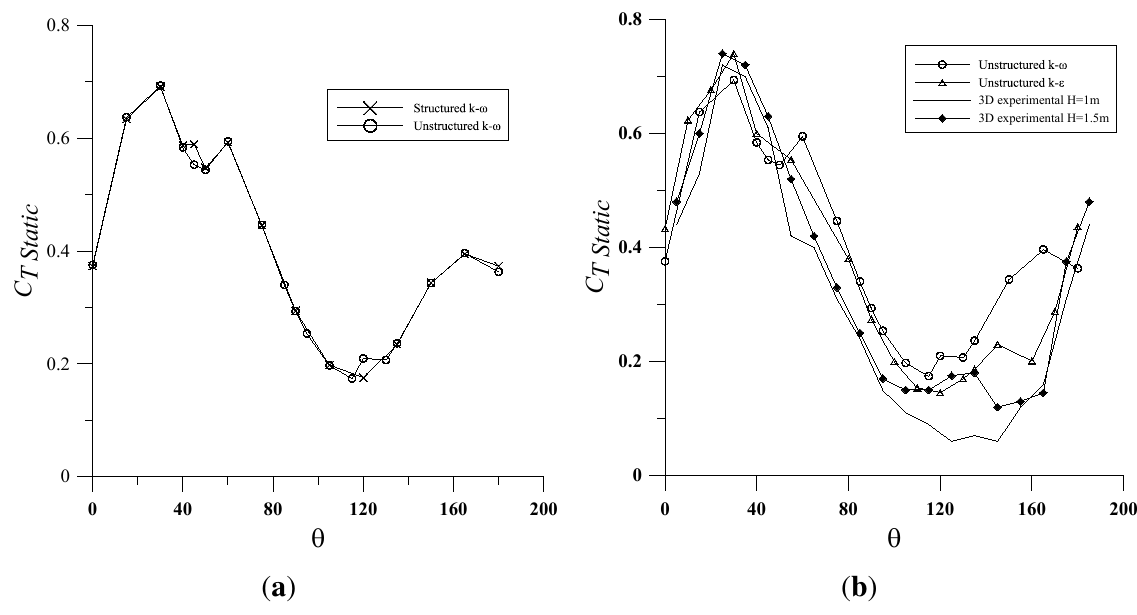
Figure 5. ( a ) Structured v.s. unstructured mesh; and ( b ) unstructured κ − (cid:15) and κ − ω model vs. experimental data